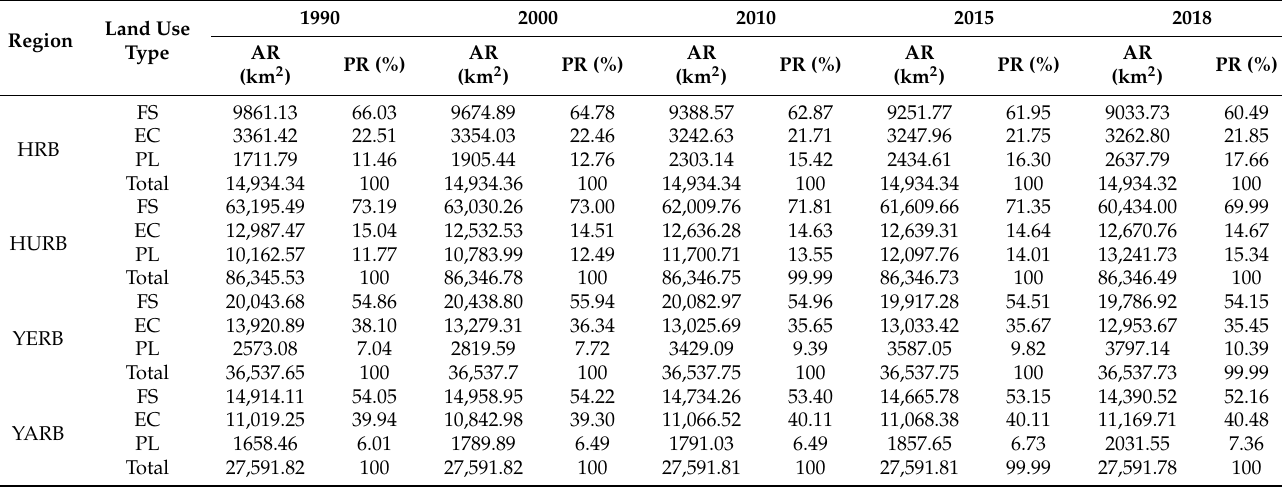
Table 3. Area and proportion of land-use types in the study area in 1990, 2000, 2010, 2015, and 2018. Region